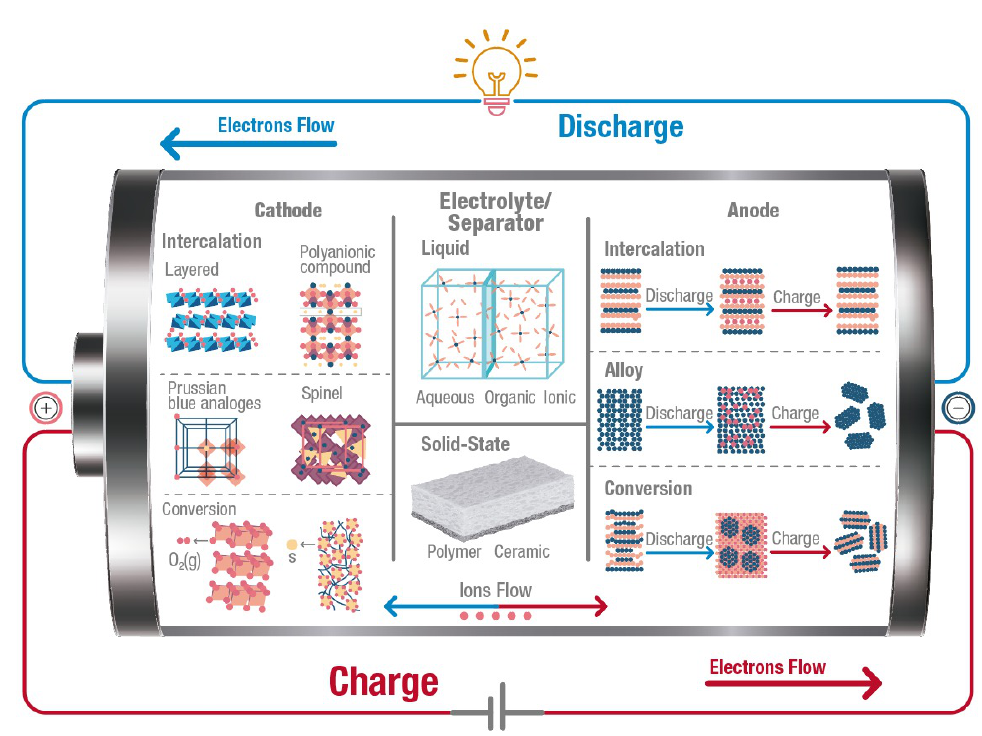
Figure 2. Illustration of the crucial internal components of a battery, showing different types of materials researched for cathodes, anodes, electrolytes, and separators. Arrows indicate the flow of electrons (through the external circuit) and ions (through the electrolyte) during the charging (red) and discharging (blue) process. Graph constructed by the